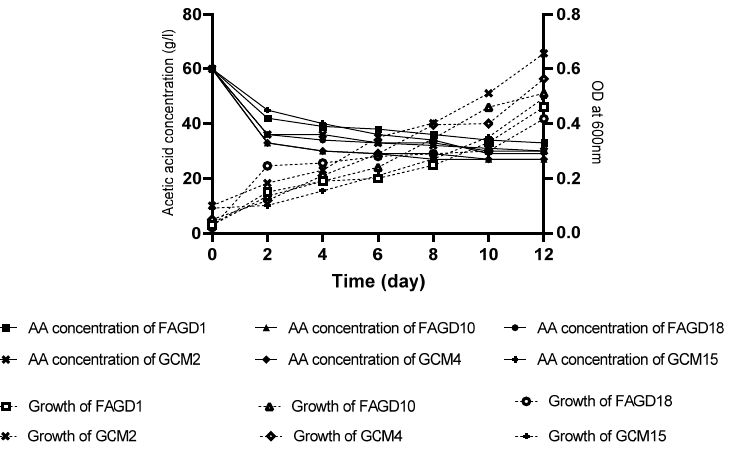
Figure 6. Evolution of acetic acid concentration and bacterial growth at 6% ( v / v ) acetic acid.